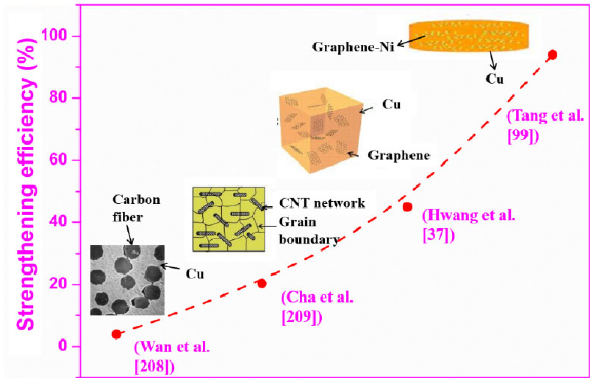
Fig. 12 Summary of progress in the strengthening efficiency of Cu matrix composites. Graphene–Ni. Reproduced with permission from Ref. [99], © Elsevier B.V. 2014. Carbon fiber. Reproduced with permission from Ref. [208], © Elsevier Science S.A. 2000. CNT network. Reproduced with permission from Ref. [209], © John Wiley and Sons 2005. Graphene. Reproduced with permission from Ref. [37], © John Wiley and Sons